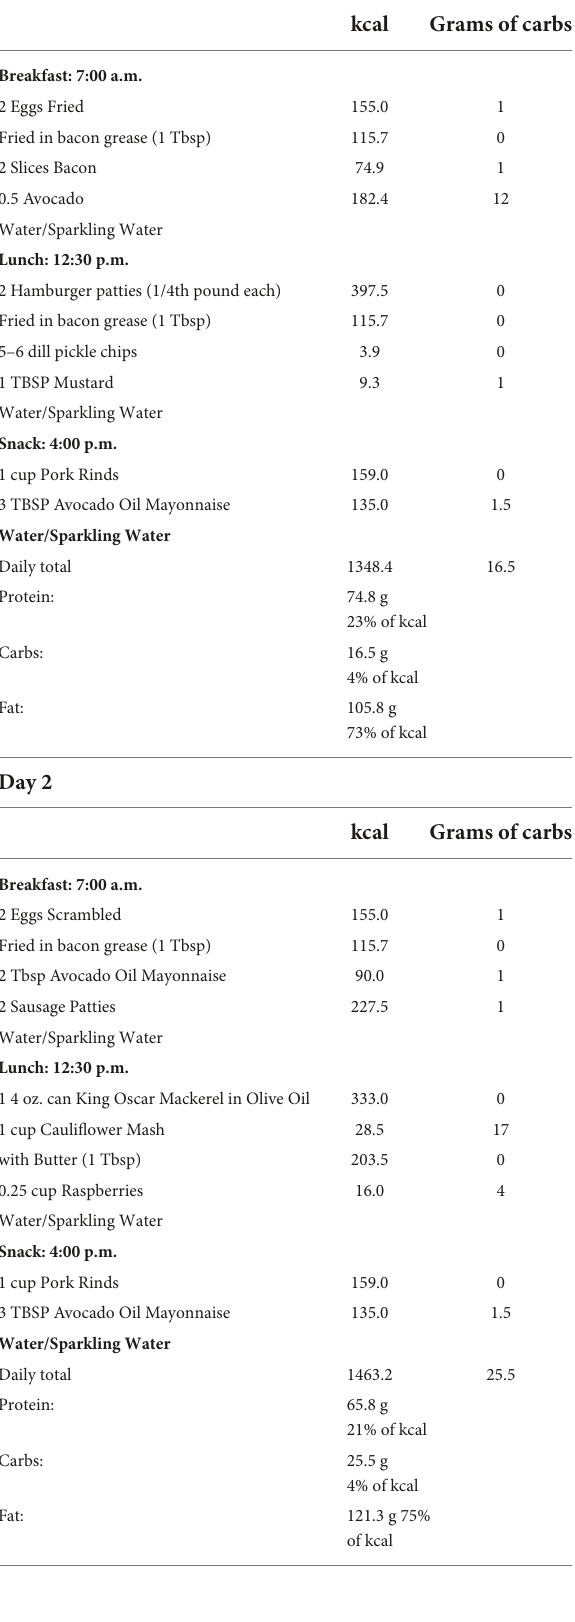
TABLE 2 Sample menus with kcal and grams of